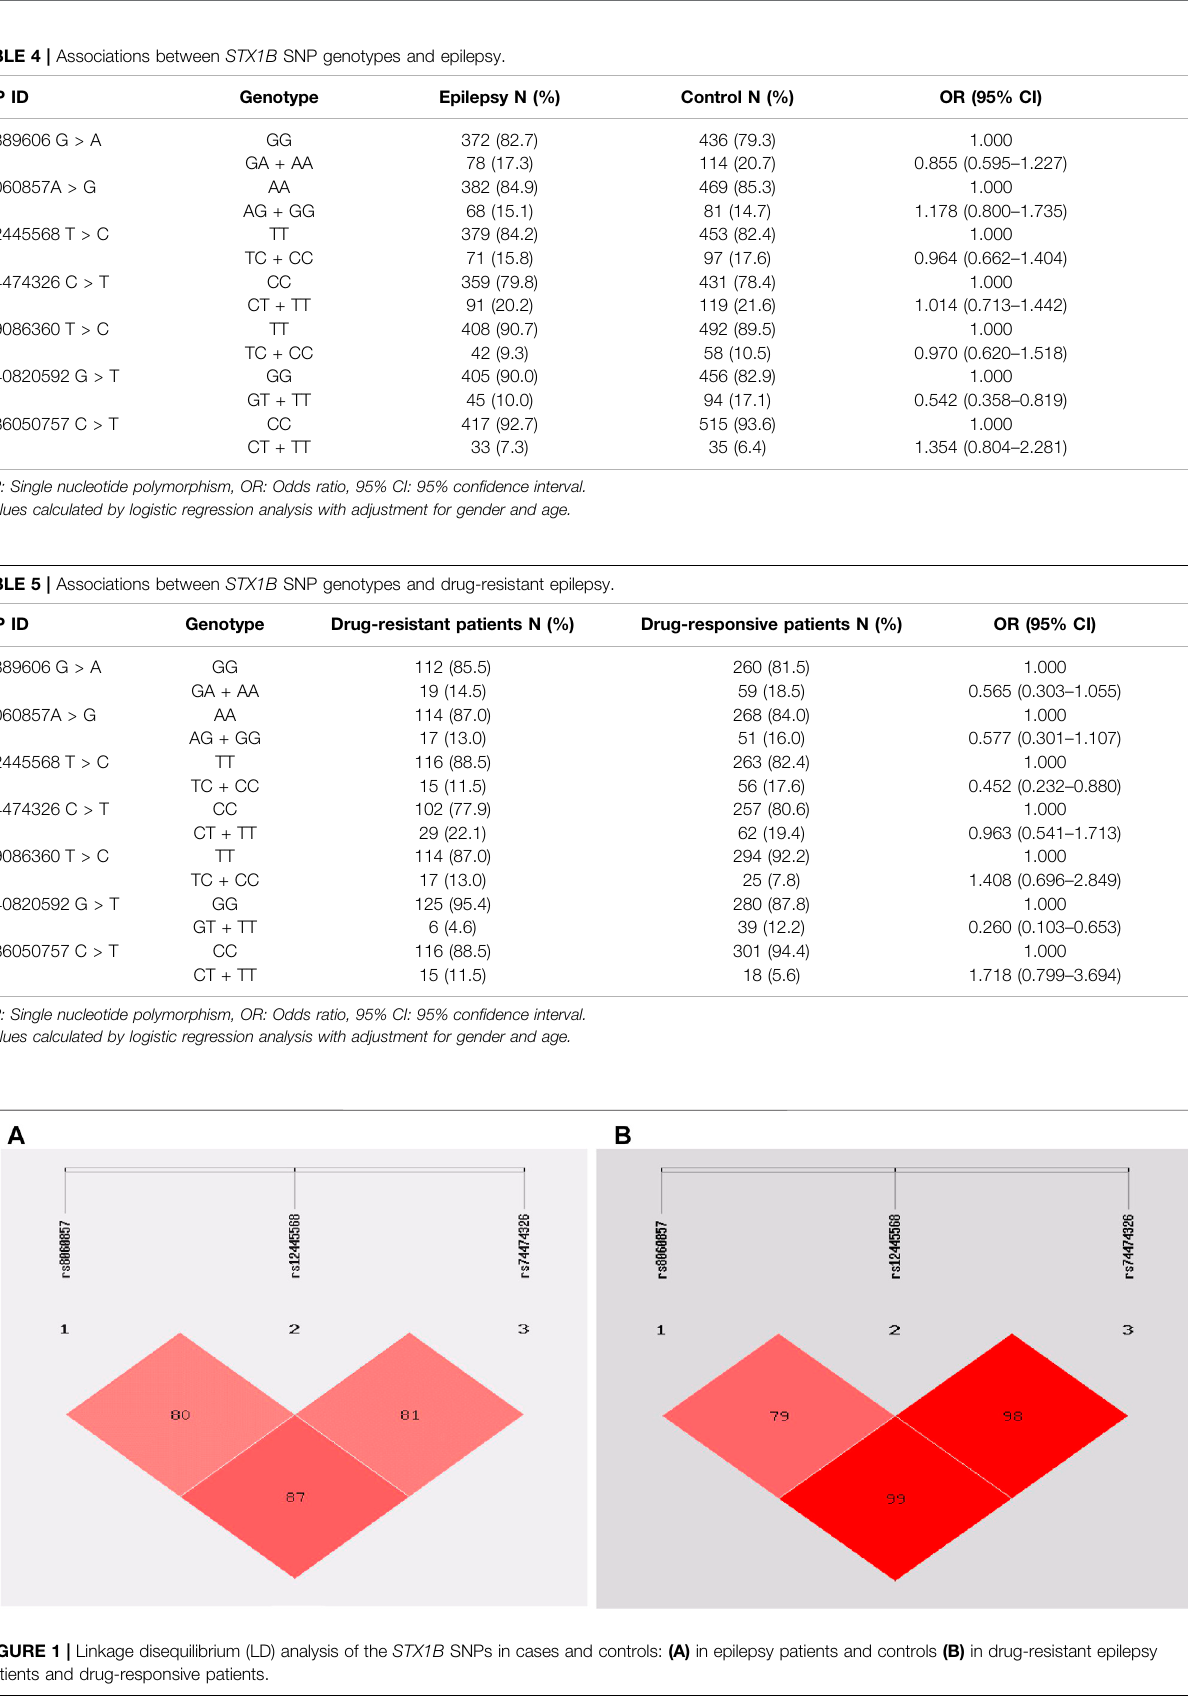
Frontiers in Pharmacology |